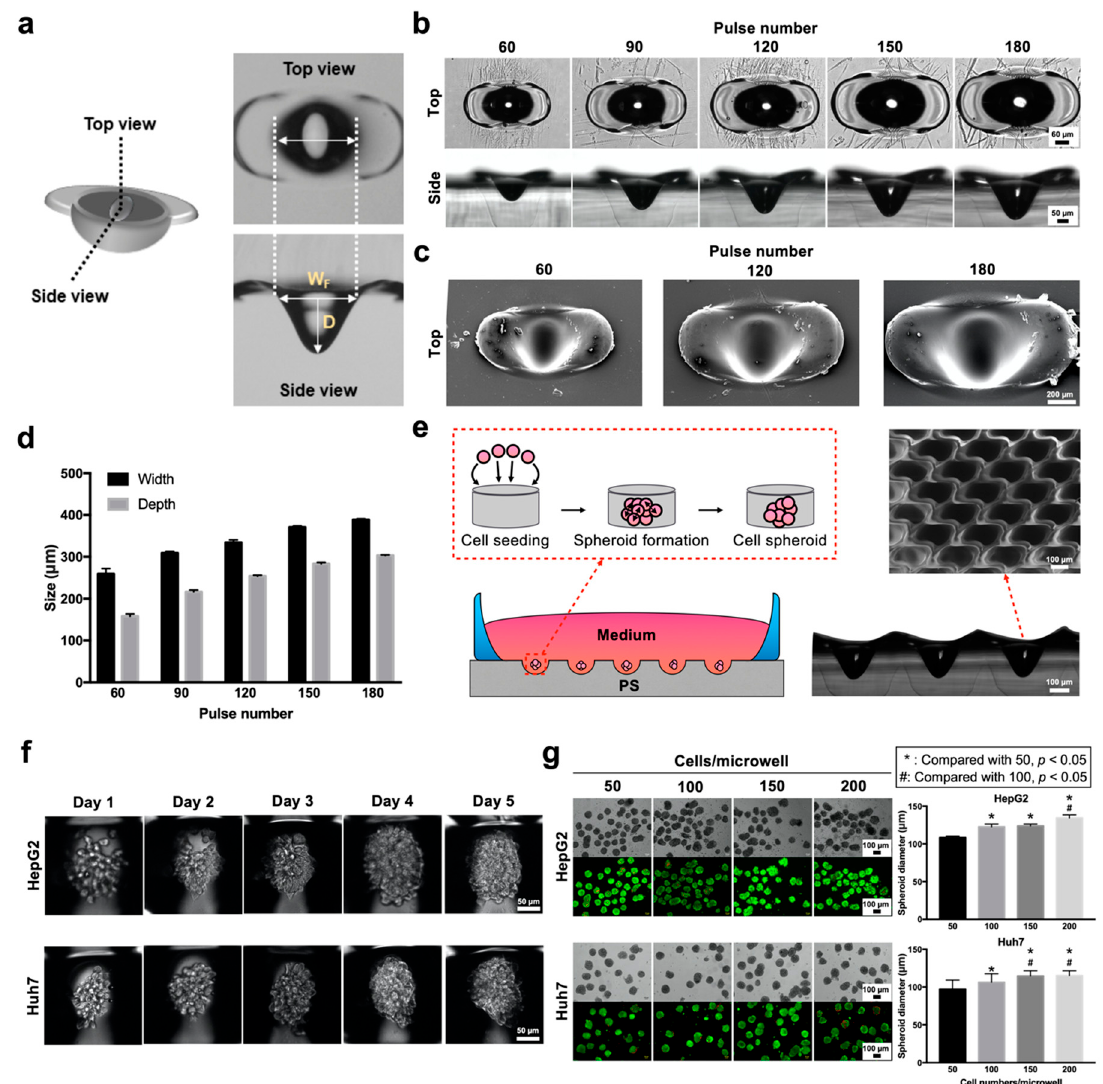
Figure 3. Characterization of polystyrene (PS) microwells made with different pulse numbers and multicellular tumor spheroid (MCTS) formation. ( a ) Illustration of ablated microwells from top and side views. ( b ) Top and side views of a single microwell with respect to pulse numbers ranging from 60 to 180. ( c ) A detailed surface profile of a single microwell recorded by SEM. ( d ) Evaluation of the widths and depths of microwells made with different pulse numbers. ( e ) Schematic diagram of spheroid formation within microwells, and a detailed profile of the microwell arrangement for spheroid formation by SEM. ( f ) MCTSs are directly shown from day 1, the day of cell seeding, to day 5 within the microwell. ( g ) Brightfield (gray) and fluorescent (live (green) / dead (red) staining) images of MCTSs with different cell number aggregates (50, 100, 150, 200 cells microwell − 1 ) (left), followed by the quantification of spheroid size with respect to the cell seeding number (per microwells) (right).